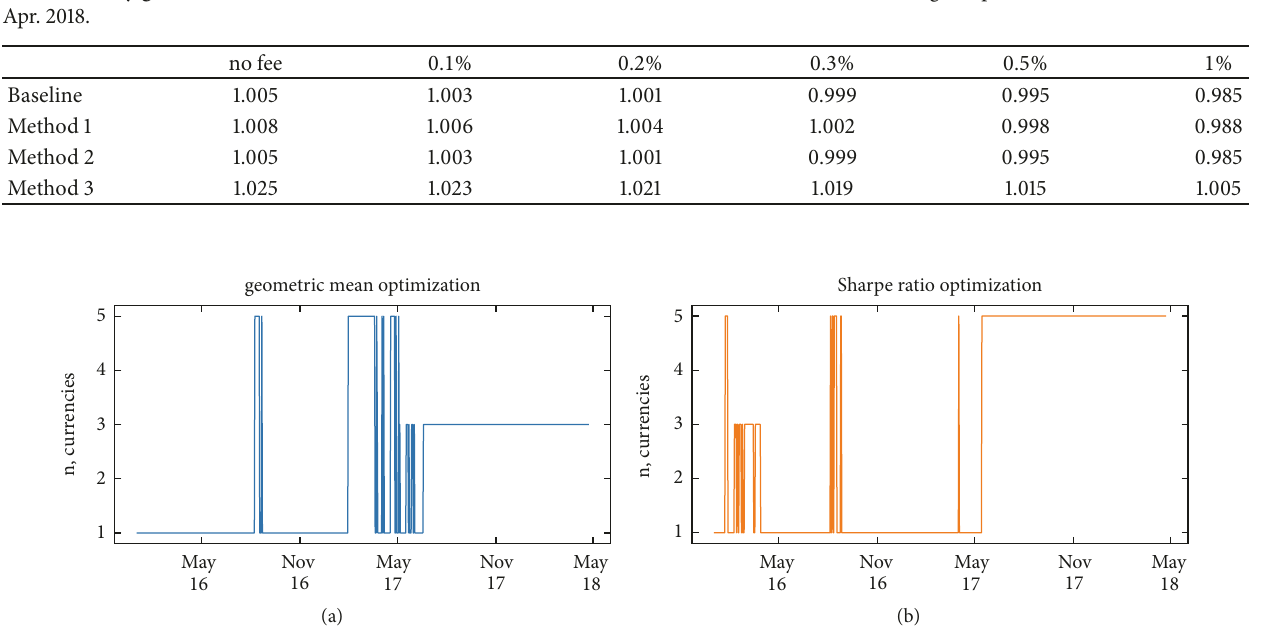
Figure 12: Method 3: parametersoptimisation. The number of currencies 𝑛 chosen over time under the geometric mean (a) and the Sharpe ratio optimisation (b). Analyses are performed considering prices in BTC.